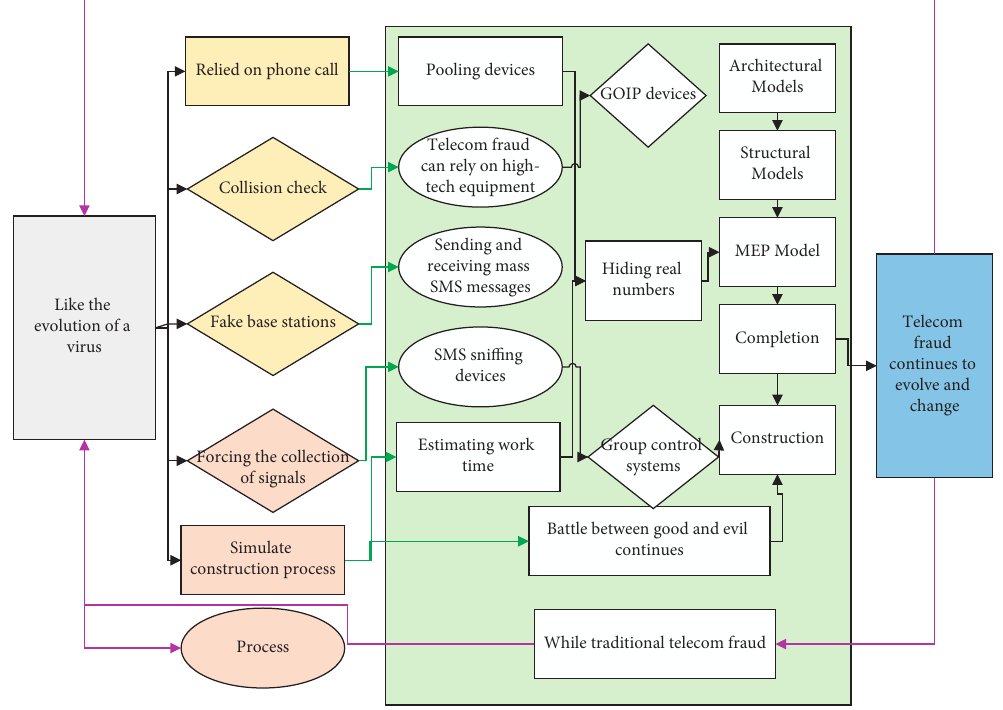
Figure 3: Organizational chart of the criminal